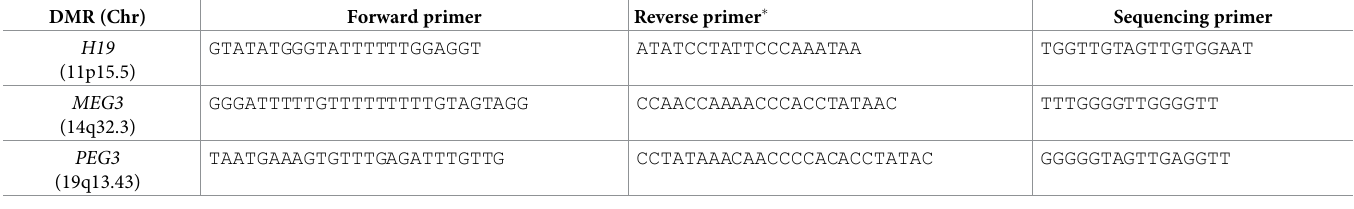
Table 1. Primer sequences for PCR